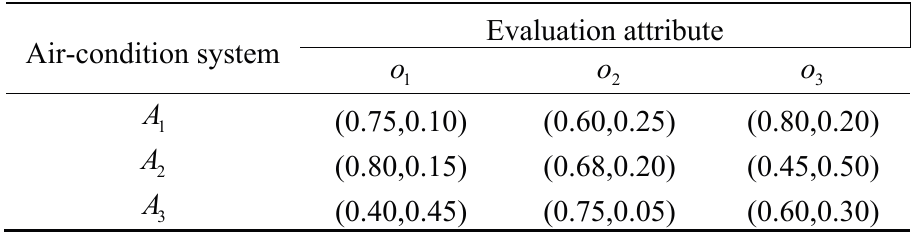
Table 4 . Intuitionistic fuzzy decision